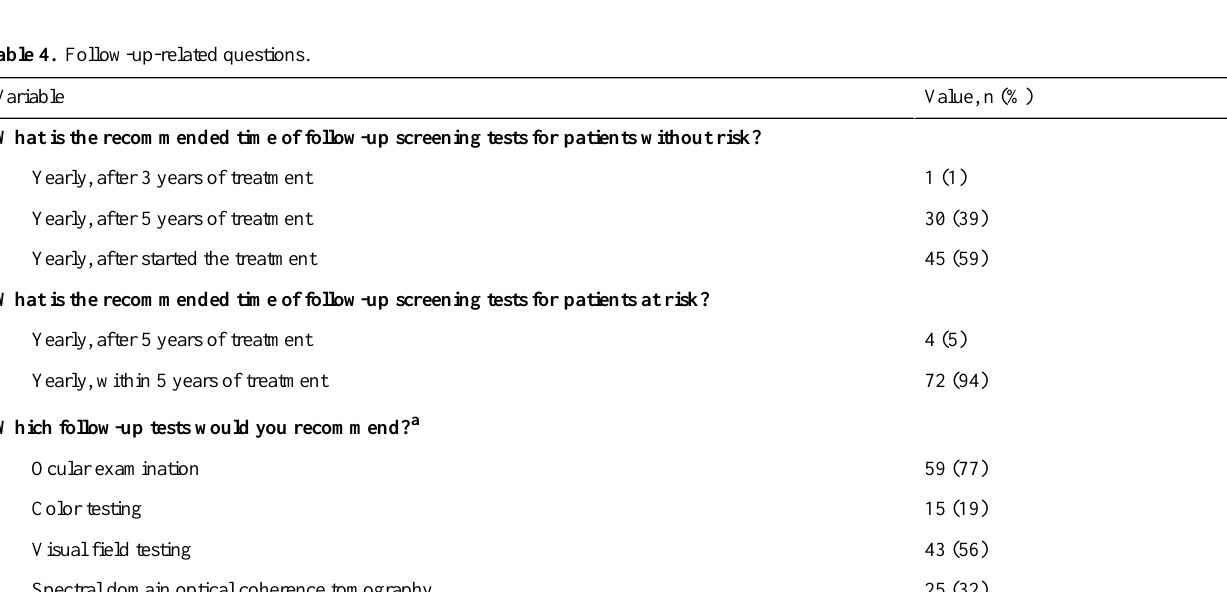
Table 4. Follow-up-related